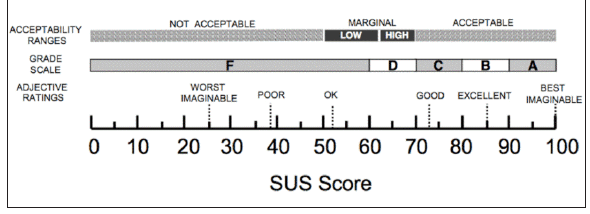
Comparison of mean system usability scale (SUS) score